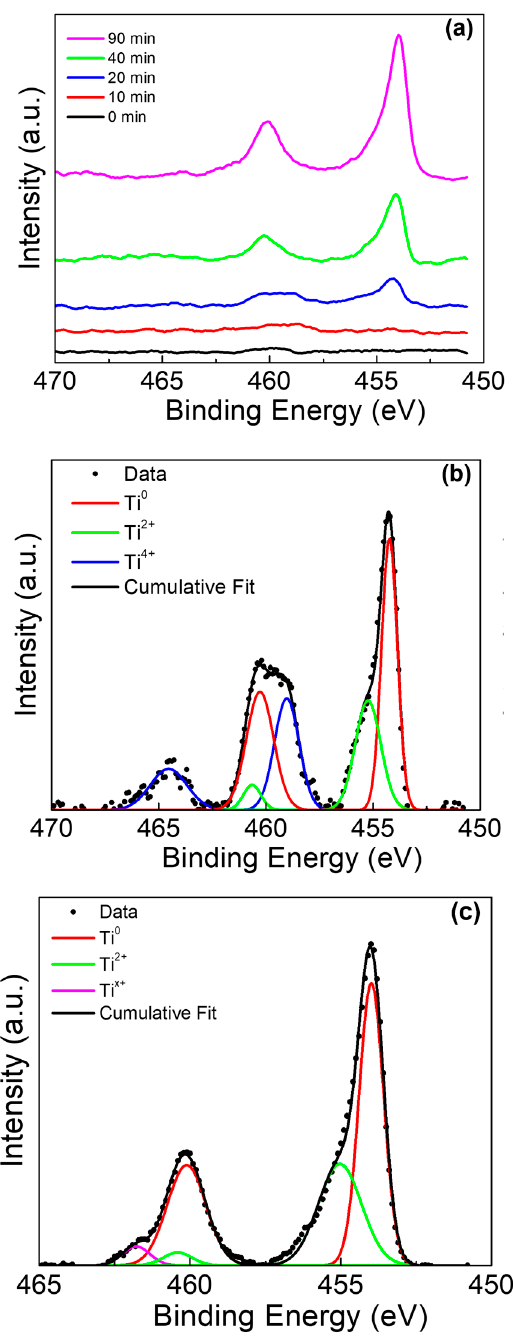
Figure 5. Ti 2p XPS of Ti rod with amalgam at pH 2. ( a ) Ti 2p peak at various sputter times, ( b ) deconvolution of 20 min sputter time, and ( c ) deconvolution of 90 min sputter time.